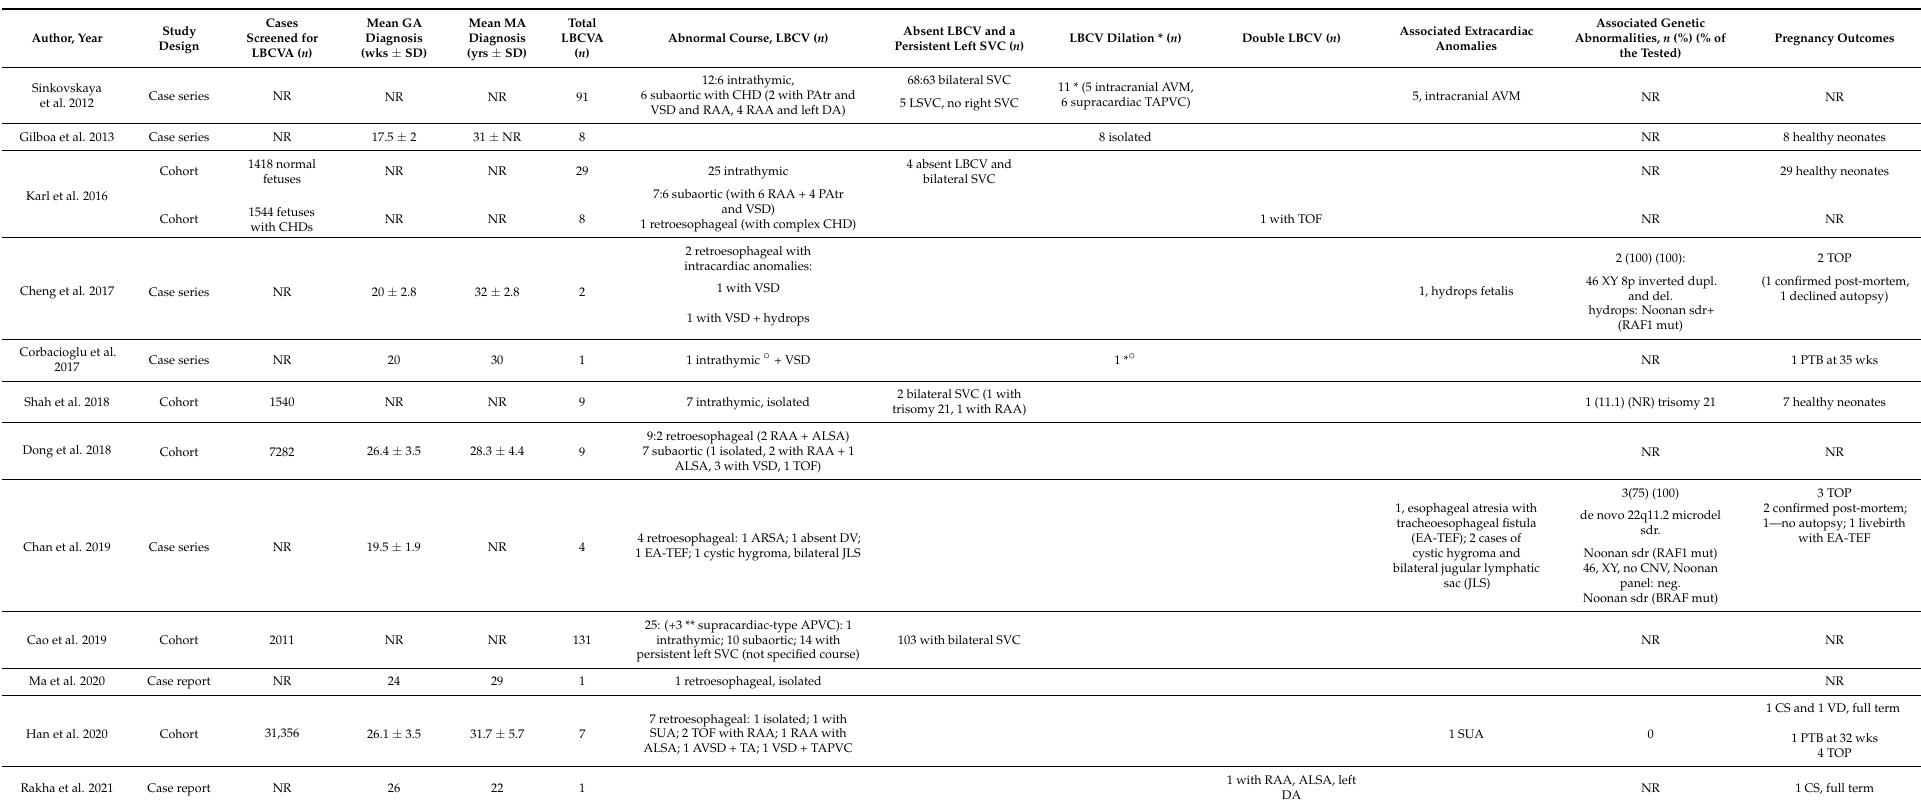
Table A1. Summary of the literature on prenatal diagnosis of the left brachiocephalic vein. All the prenatal diagnoses were carried out by means of ultrasound and echocardiography, except for those performed by Dong et al. (fetal